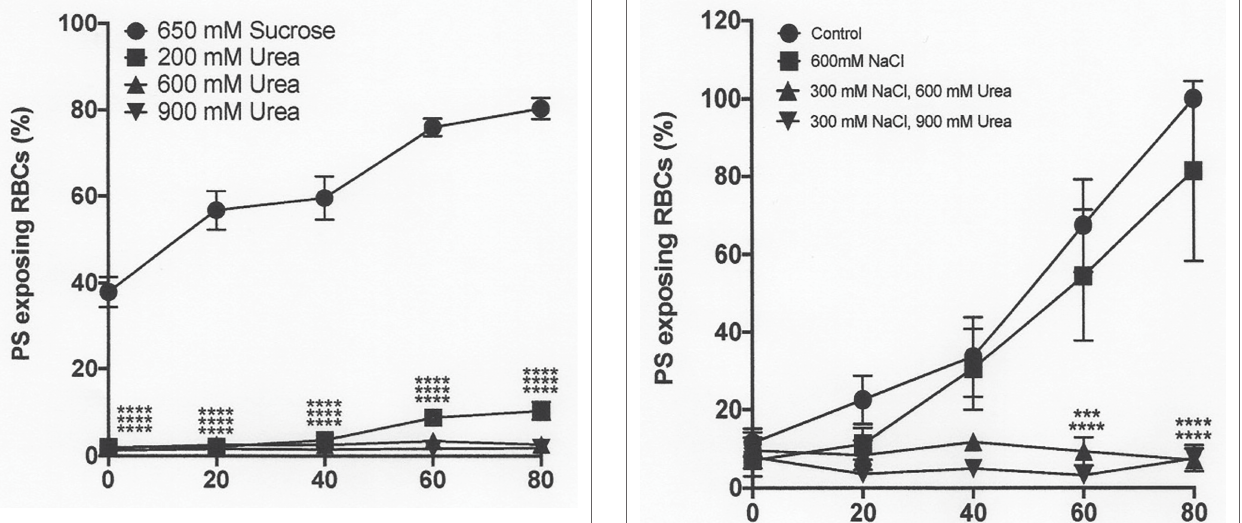
FIGURE 8 | The effect urea and hypertonic sucrose on phosphatidylserine exposure in deoxygenated red cells from patients with SCA. Red cells (1% Hct) were incubated in Eschweiler tonometers at 37 o C, pH 7.4 and at an osmolality of 940 mOsm.kg-1, through addition of hypertonic sucrose, for up to 80 min under fully deoxygenated conditions (0 mmHg oxygen) in the absence of urea (650 mM Sucrose) or at three different urea concentrations (200, 600, and 900 mM, all also with 650 mM Sucrose). At the time intervals indicated, red cell aliquots were removed and PS exposure measured using LA-FITC, as described in the Methods. Symbols represent means ± SEM, n = 3. **** p < 0.0001, comparing red cells in the absence of urea with those in its